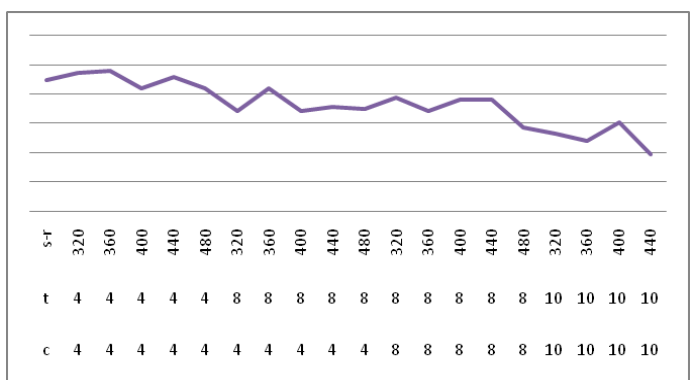
Figure 9. The ECG verification success